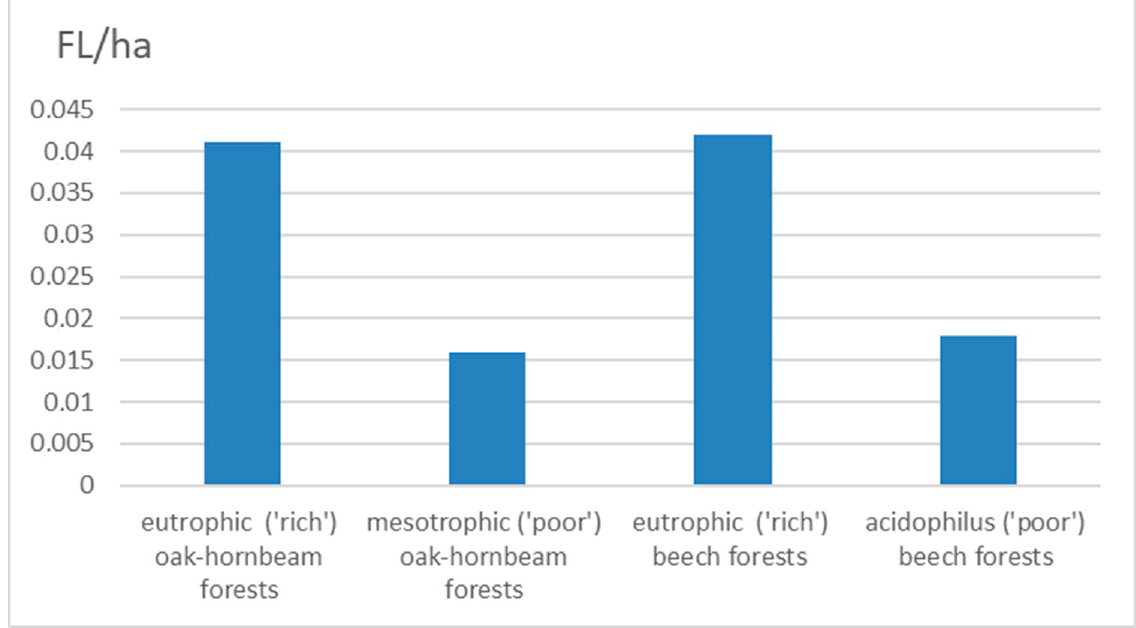
Figure 4. Number of fir localities (FL) per unit surface area of the most important groups of potential natural vegetation in the area covered by the study.